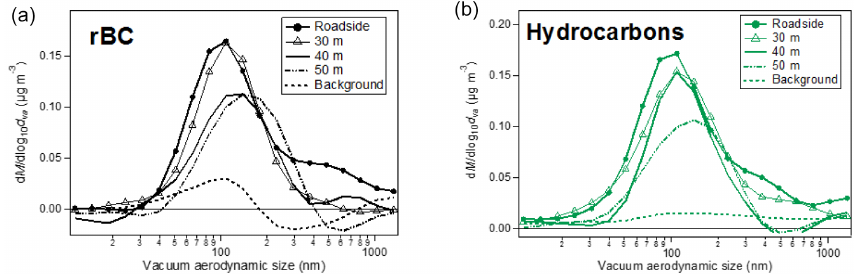
Figure 7. Particle mass size distribution at Herttoniemi on 26 October 2012. m/z 36 was used as a surrogate for rBC and m/z 57 for